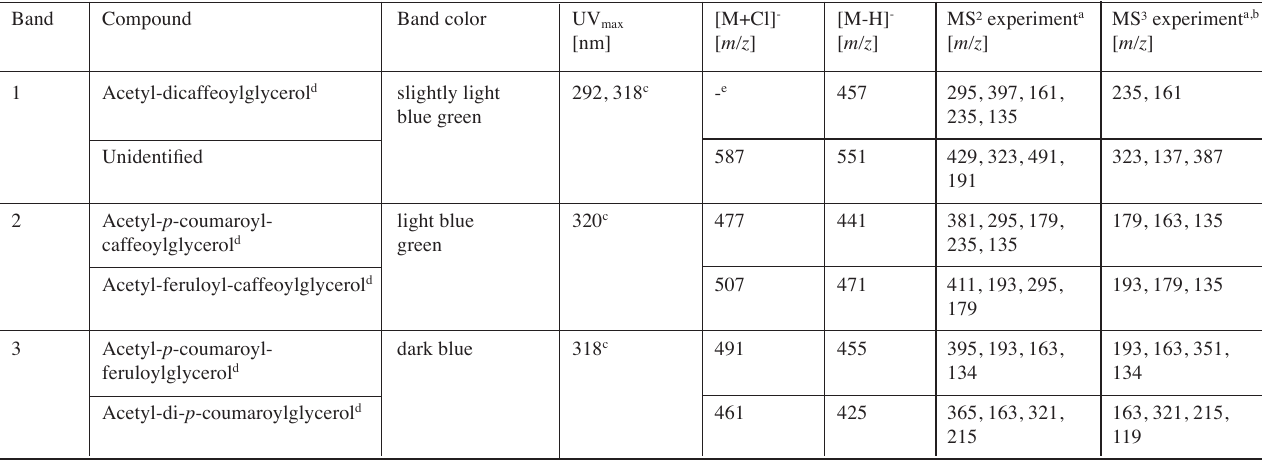
Tab. 4: TLC-MS and UV spectroscopic data obtained for the analysis of P. tremula L. (see Fig.